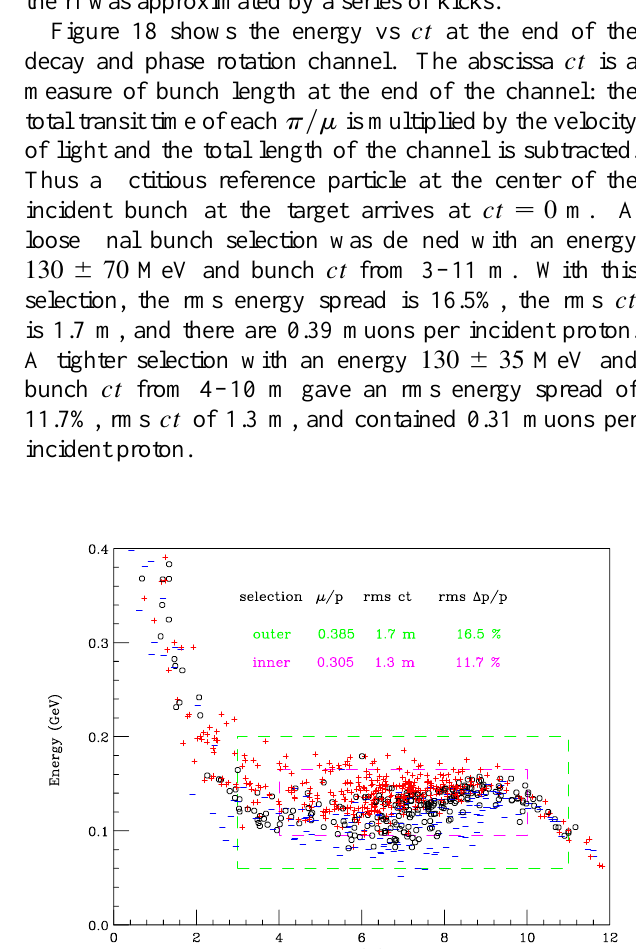
, P , 1 , 2 1 , and 3 3 3